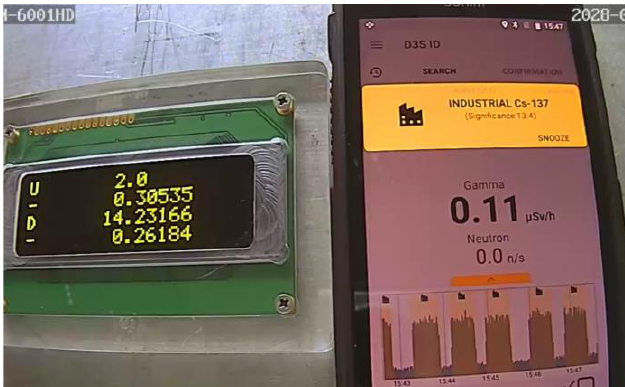
Fig. 2. Exemplarily screenshot of a test. On the left the timer and on the right the display part of the device to be tested, the D3S (see section IV).